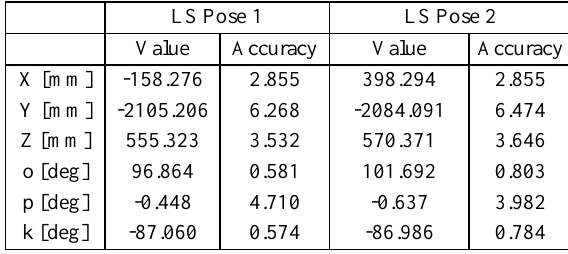
Table 2 . Results of the first feasibility study with two LS poses